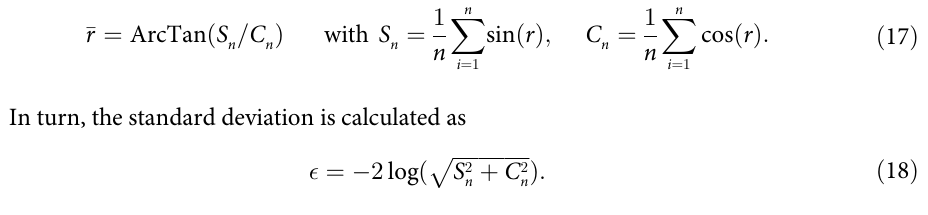
ffiffiffiffiffiffiffiffiffiffiffiffiffiffiffi p Þ : ð 18 Þ þ C 2 S 2 n n